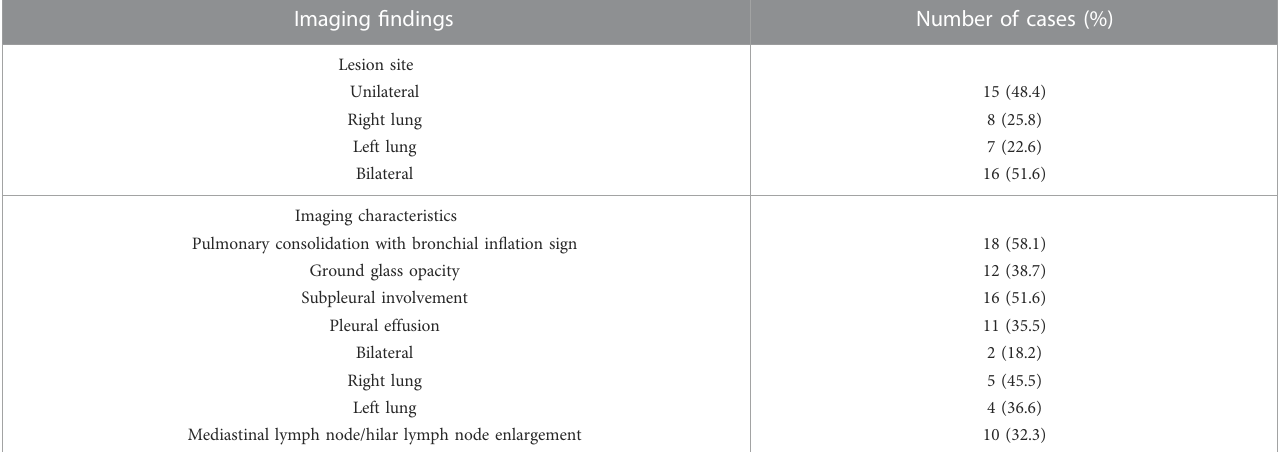
TABLE 5 Imaging manifestations of 31 patients with severe C. psittaci